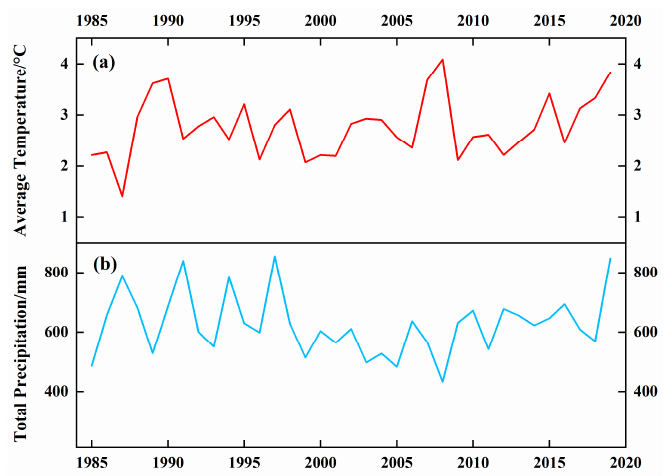
Figure 9. Annual mean temperature from 1985 to 2019 in the HNNR ( a ); annual precipitation from 1985 to 2019 in the HNNR ( b ).